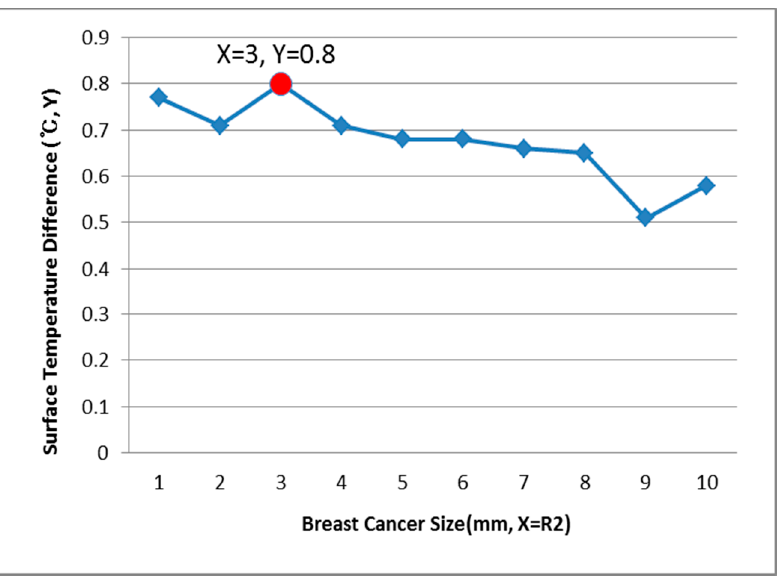
Figure 11. Surface temperature difference for R1 of 80 mm (X = 10, Y = 0).